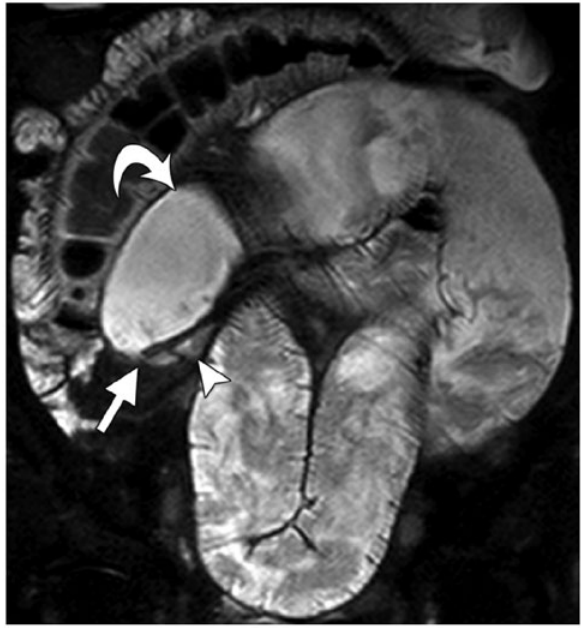
Figure 10: Reproduced with permission from: Amzallag-Bellenger E, Oudjit A, Ruiz A, et al. Effectiveness of MR enterography for the assessment of small-bowel diseases beyond Crohn Disease. RadioGraphics 2012;32:1423–1444. Adhesive ileal obstruction in a 30-year-old woman with a history of appendectomy and recurrent low-grade bowel obstruction. MR enterography was performed after the administration of 1 litre of an oral contrast agent. Coronal FISP image from MR enterography demonstrates ileal loop dilatation (curved arrow), a transition point (straight arrow), and normal distal caliber (arrowhead). No mass, bowel wall thickening, stricture, or other specific cause of obstruction was identified. These findings were suggestive of an obstruction due to bowel adhesion, which was later confirmed at laparotomy